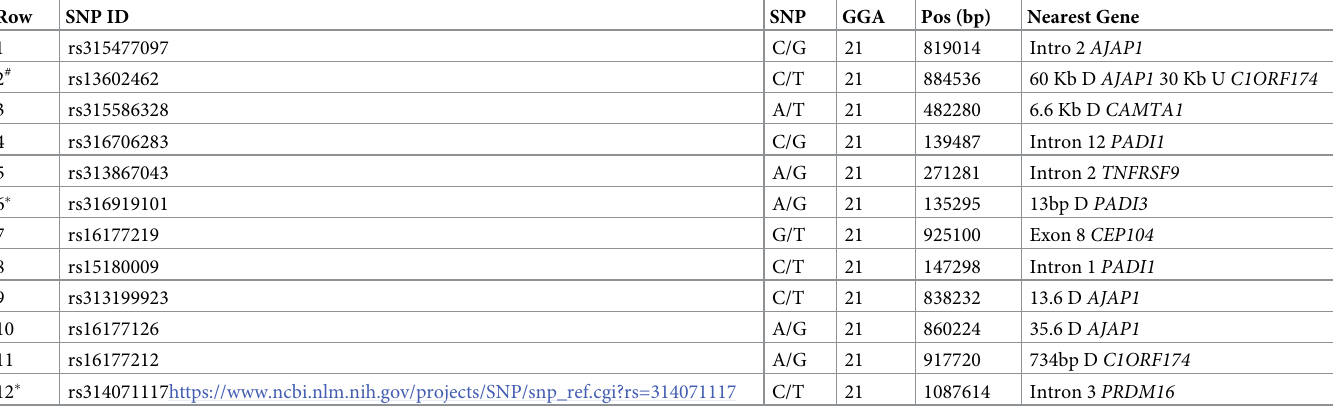
Table 4. SNP markers involved in the association analysis for N146 and N280 populations.